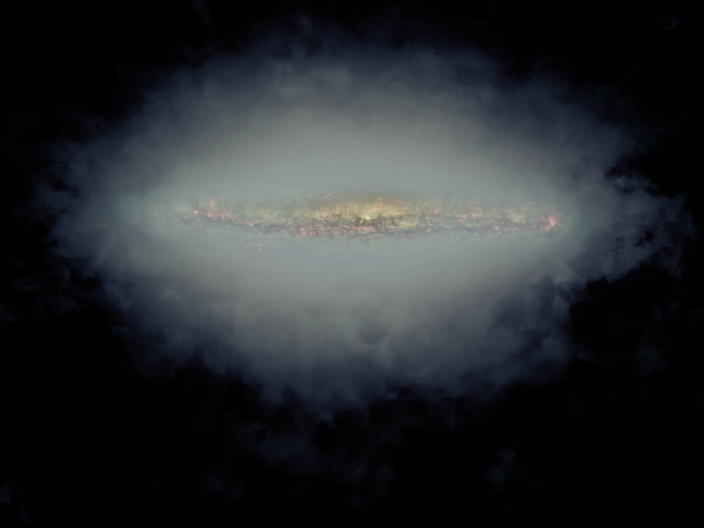
Figure 3. The median edge-on spiral galaxy (in blue-grey) in L-band made from stacking 30 of the CHANG-ES galaxies all scaled to the same angular size. The median image is superimposed on an optical Hubble Space Telescope image of NGC 5775. Modified from [3] by Jayanne English (NRAO/AUI/NSF;